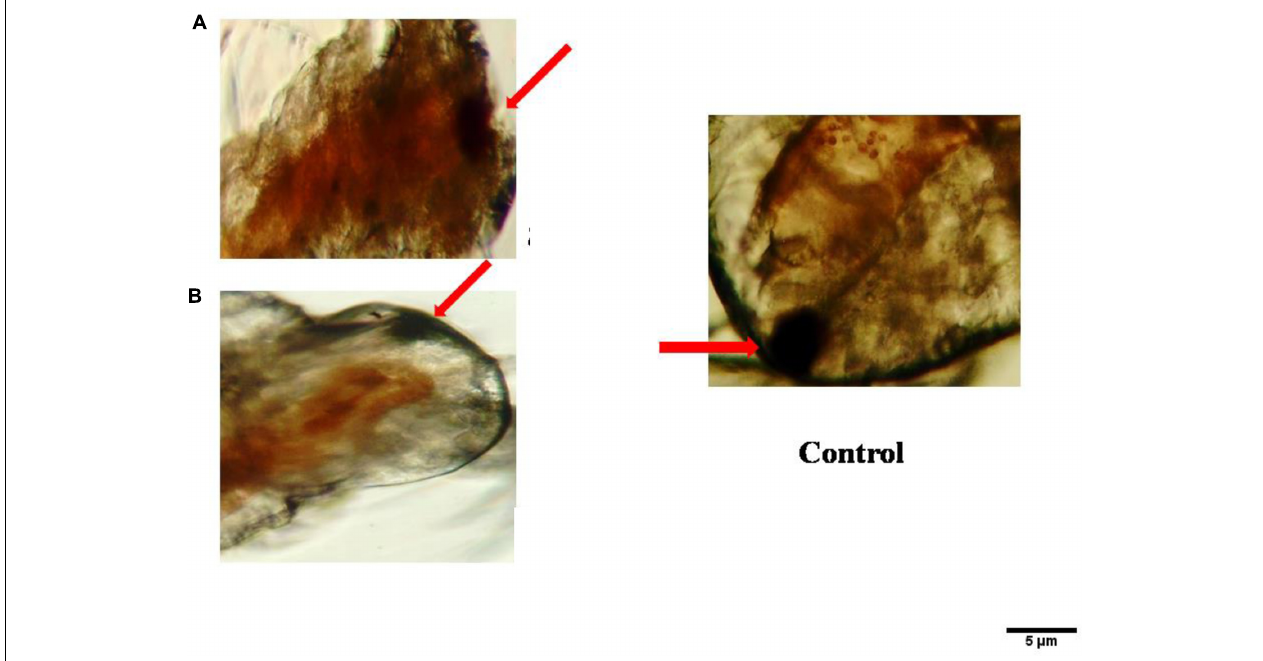
FIGURE 5 | Visible anomalies in Artemia nauplii subjected to different concentrations of P. daleae mycelium ethyl acetate extract. Control A. nauplii not exposed to any extract. While the normal eye is round and black (control), extract exposed nauplii had changes in the eyeball shape (A) , loss of eye color, and fading of eyes (B) . The A. nauplii were observed periodically under light microscope (Labomed at